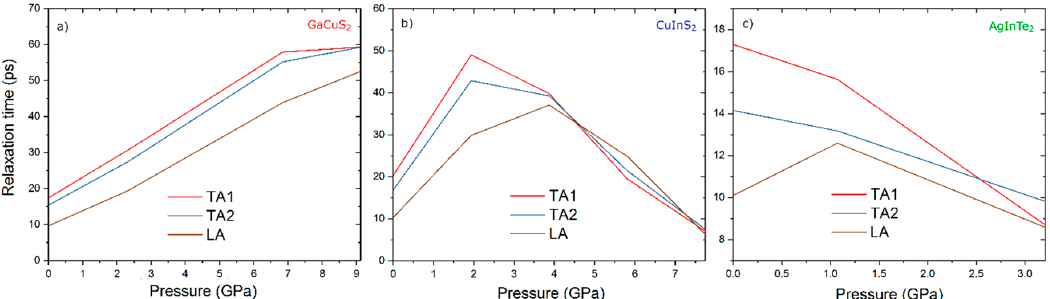
Figure 4. Phonon relaxation time under pressure of ( a ) CuGaS 2 , ( b ) CuInS 2 , and ( c ) AgInTe 2 . TA1 and TA2 are two transverse acoustic modes, and LA is a longitudinal acoustic mode.